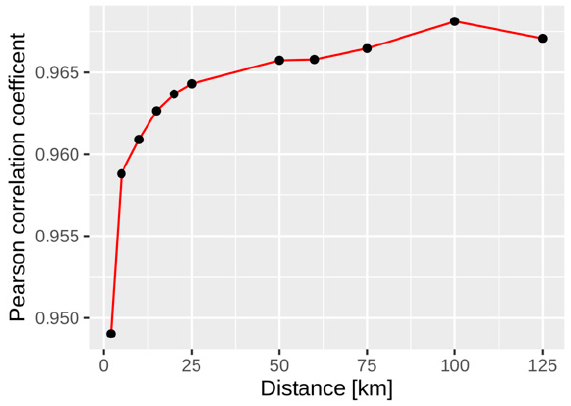
Figure 2. Pearson correlation coefficient (SEVIRI LST vs. ERA5 Land skin temperature) computed on different distances from the LST missing data areas.